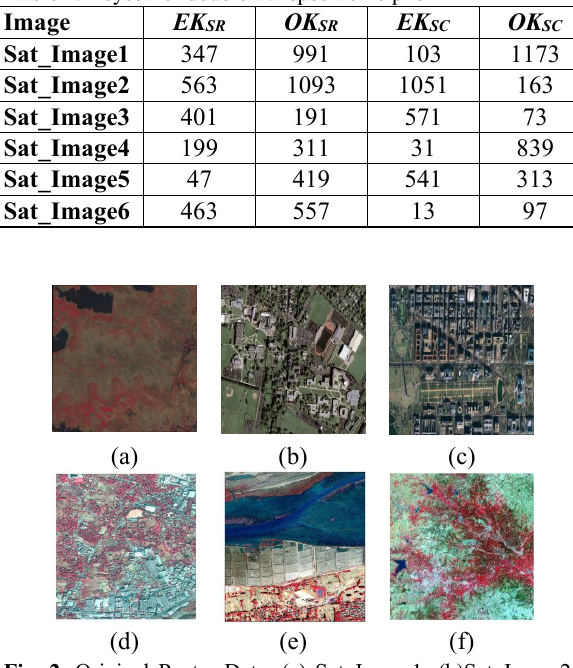
Fig. 2 . Original Raster Data: (a) Sat_Image1; (b)Sat_Image2;